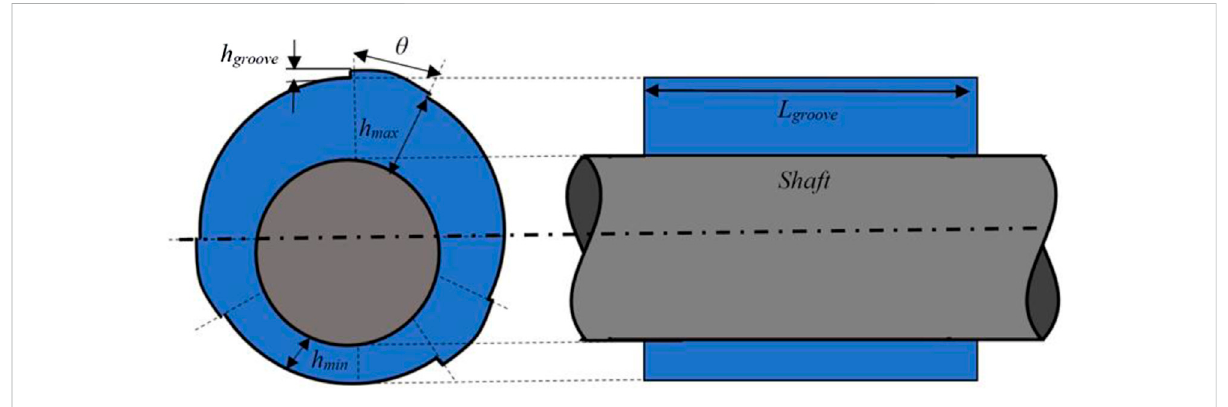
FIGURE 2 Nomenclature of multistep journal bearings.